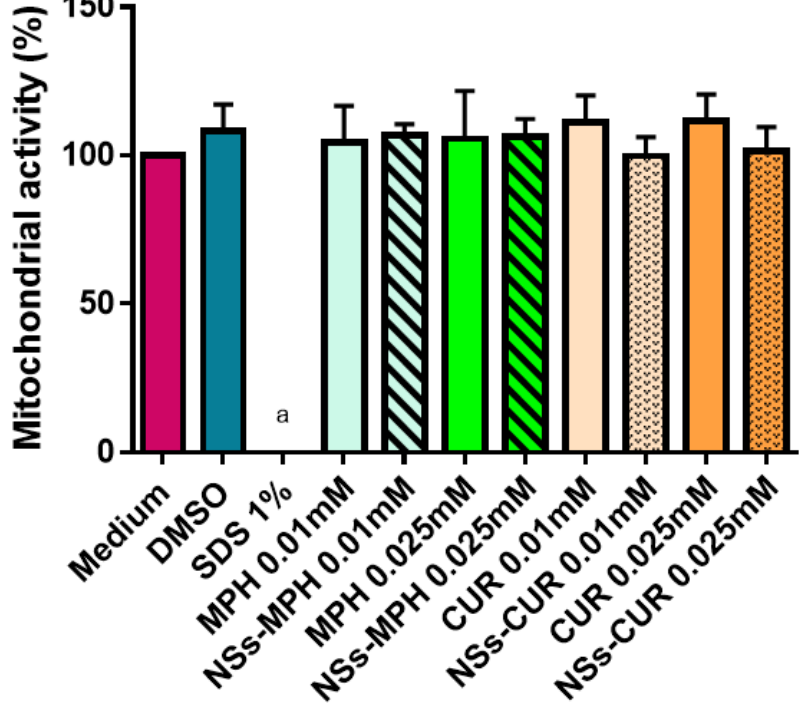
Figure A2. Effects of MPH, CUR, NSs–MPH and NSs–CUR on mitochondrial activity, as determined with the MTS assay. The results are expressed as percentages compared with untreated cells (medium) and represent the mean ± SD of n = 3 (a = **** p < 0.0001).